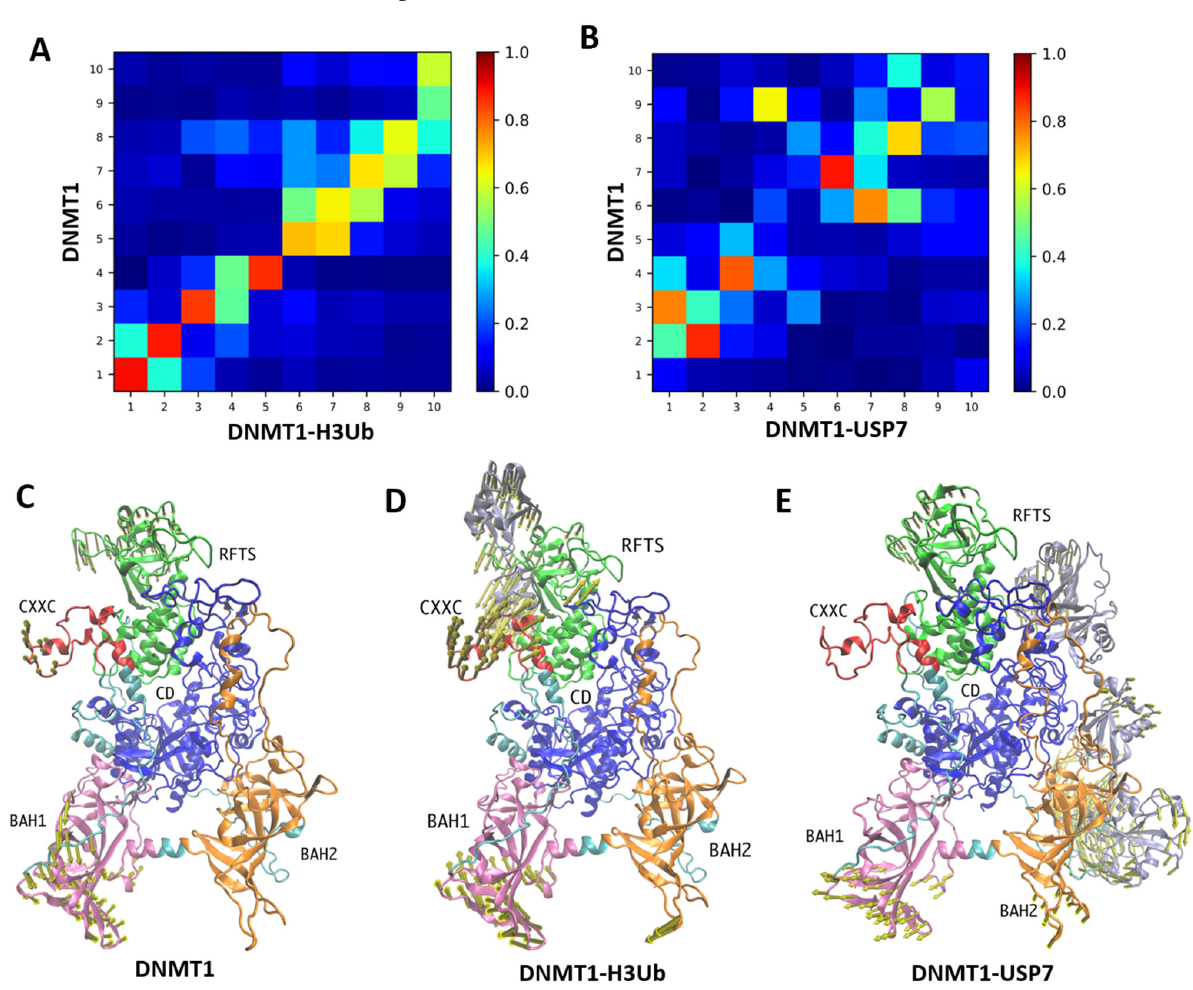
Figure 3. Intrinsic dynamics of three DNMT1 systems. ( A ) Overlaps between the ten slowest modes of DNMT1 monomer in isolated and H3Ub binding complex. ( B ) Overlaps between the ten slowest modes of DNMT1 monomer in isolated and USP7 binding complex states. The motions of the second ANM modes for the isolated ( C ) DNMT1, ( D ) DNMT1-H3Ub, and ( E ) DNMT1-USP7.